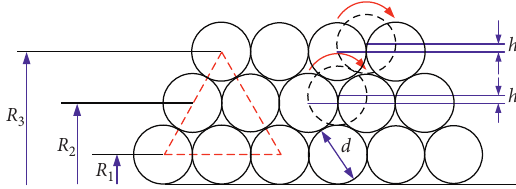
Figure 3: Process of coil crossover of rope on the